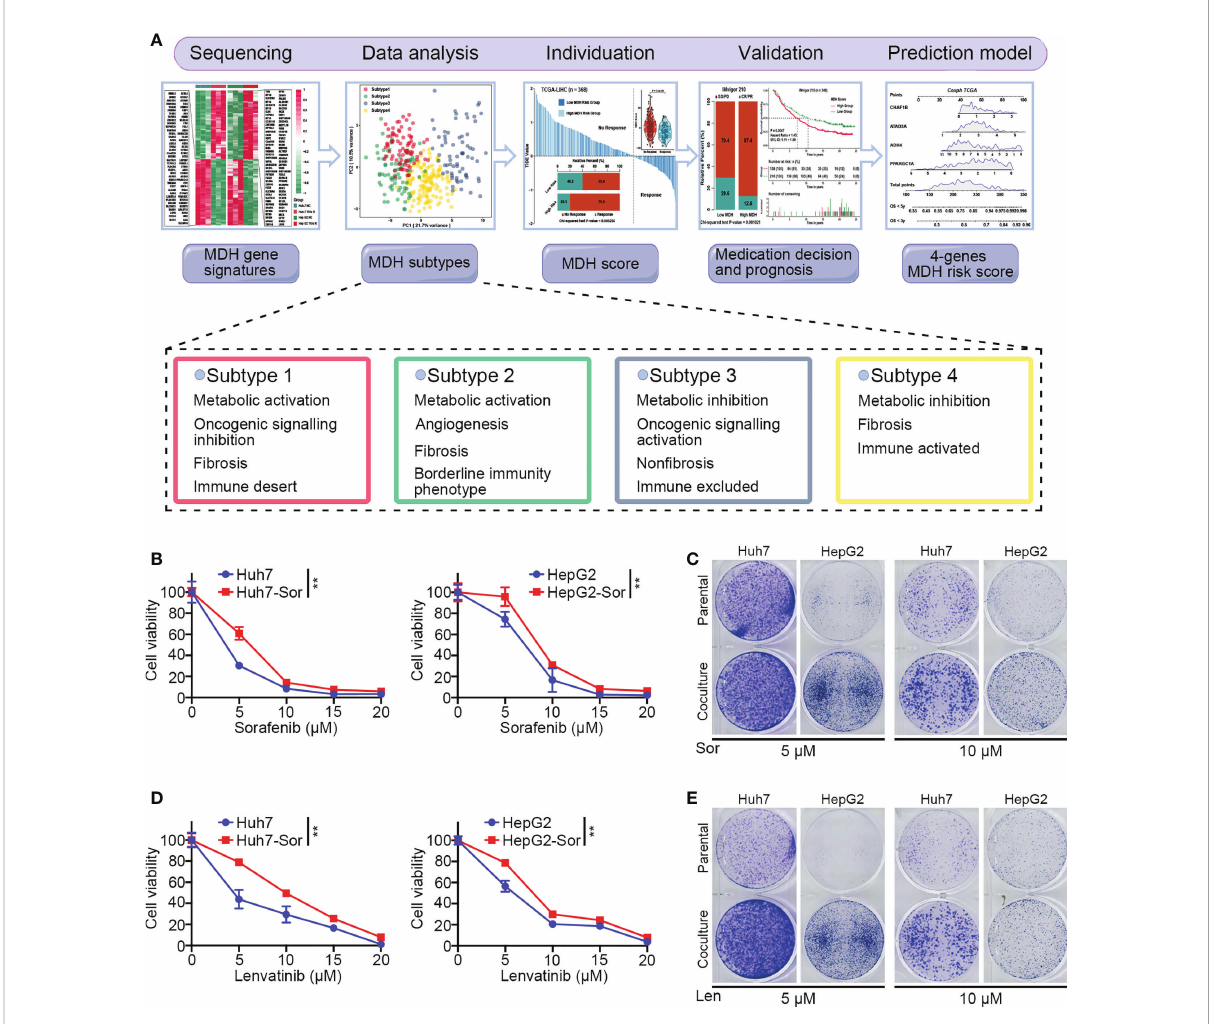
FIGURE 1 The culture of HCC sorafenib-resistant cell lines. (A) Schematic overview of the work fl ow in this study. (B) CCK-8 assays for parental HCC cells and corresponding sorafenib-resistant HCC cells treated with a range of concentrations of sorafenib. Cell viability was assessed 3 d after sorafenib treatment. (C) Clonogenic cell survival assay in speci fi ed cells treated with sorafenib for 24 h. (D) CCK-8 assays for parental HCC cells and corresponding sorafenib-resistant HCC cells treated with a range of concentrations of lenvatinib. Cell viability was assessed 5 d